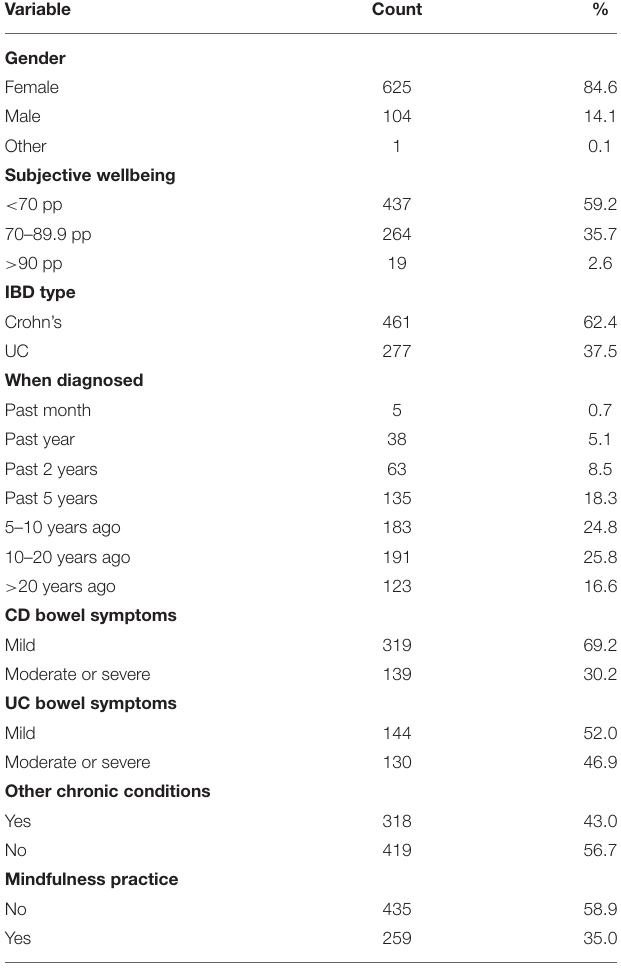
TABLE 1 | Sample’s demographic and clinical